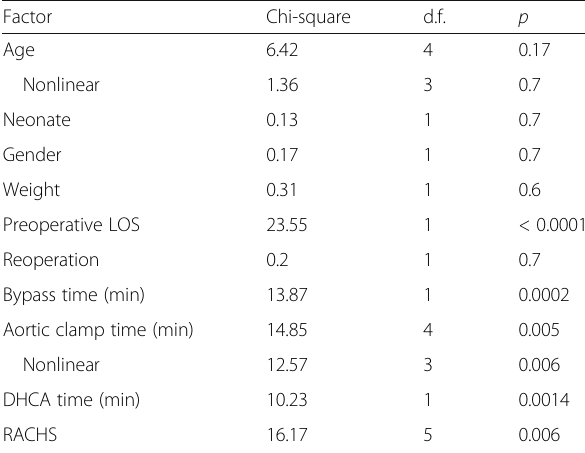
Table 3 Wald statistics of logistic regression, outcome: postoperative LOS > 14 days in